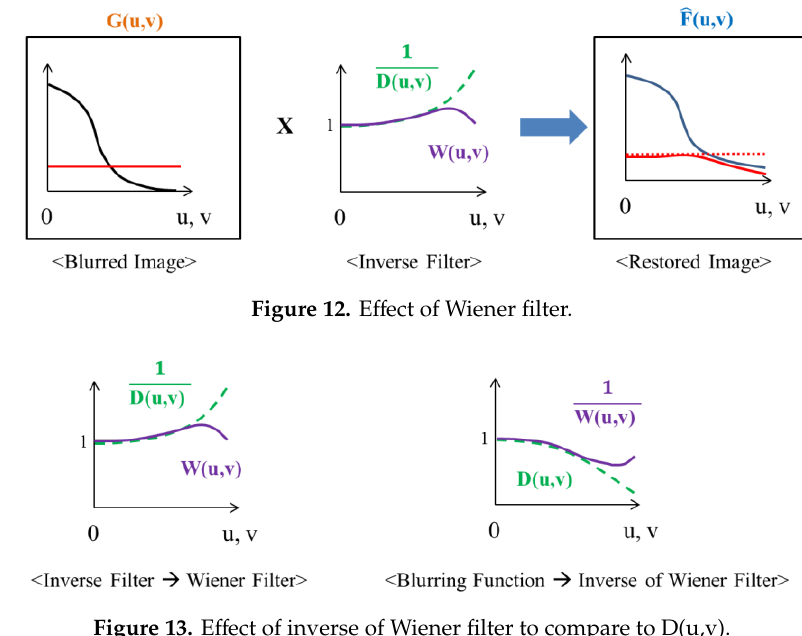
Figure 13. E ff ect of inverse of Wiener filter to compare to Figure 13. Effect of inverse of Wiener filter to compare to D(u,v). Figure 13. Effect of inverse of Wiener filter to compare to D(u,v).